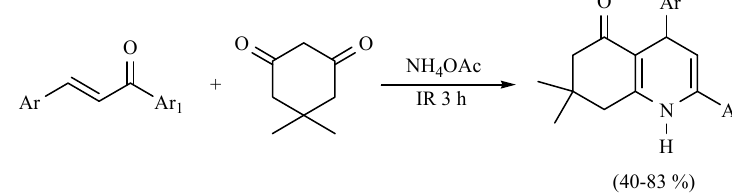
Scheme 25. Production of